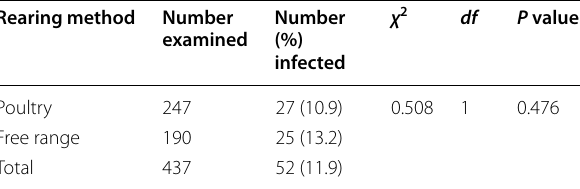
Table 1 Prevalence of Cryptosporidium oocysts in relation to method of rearing Rearing method